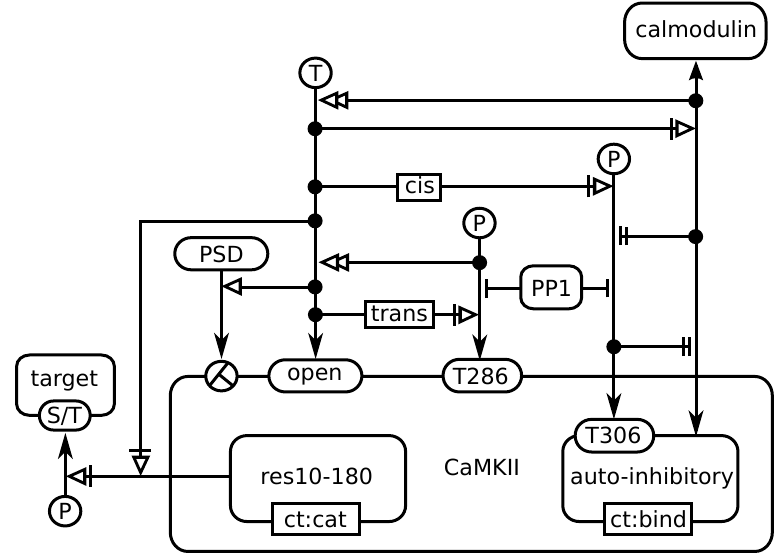
Figure 2.42: Illustration of the use of domains . This map contains five entities . Three are top-level, while the entities “res10-180” and “auto-inhibitory” are domains of the en- tity “CaMKII”. The controlled terms carried by the units of information tell us that those domains are a catalytic domain and a binding site respectively. As far as the relation- ships with the entities “calmoduline” and “target” are concerned, the interpretation does not differ from the one we would derive from a map where all the entities would be entirely separated. However the regulation of localisation of “CaMKII” to the post-synaptic densite (PSD) by phosphorylation of threonine 286 also causes the localisation of “res10-180” and “auto-inhibitory”, even if none carry the state variables involved.